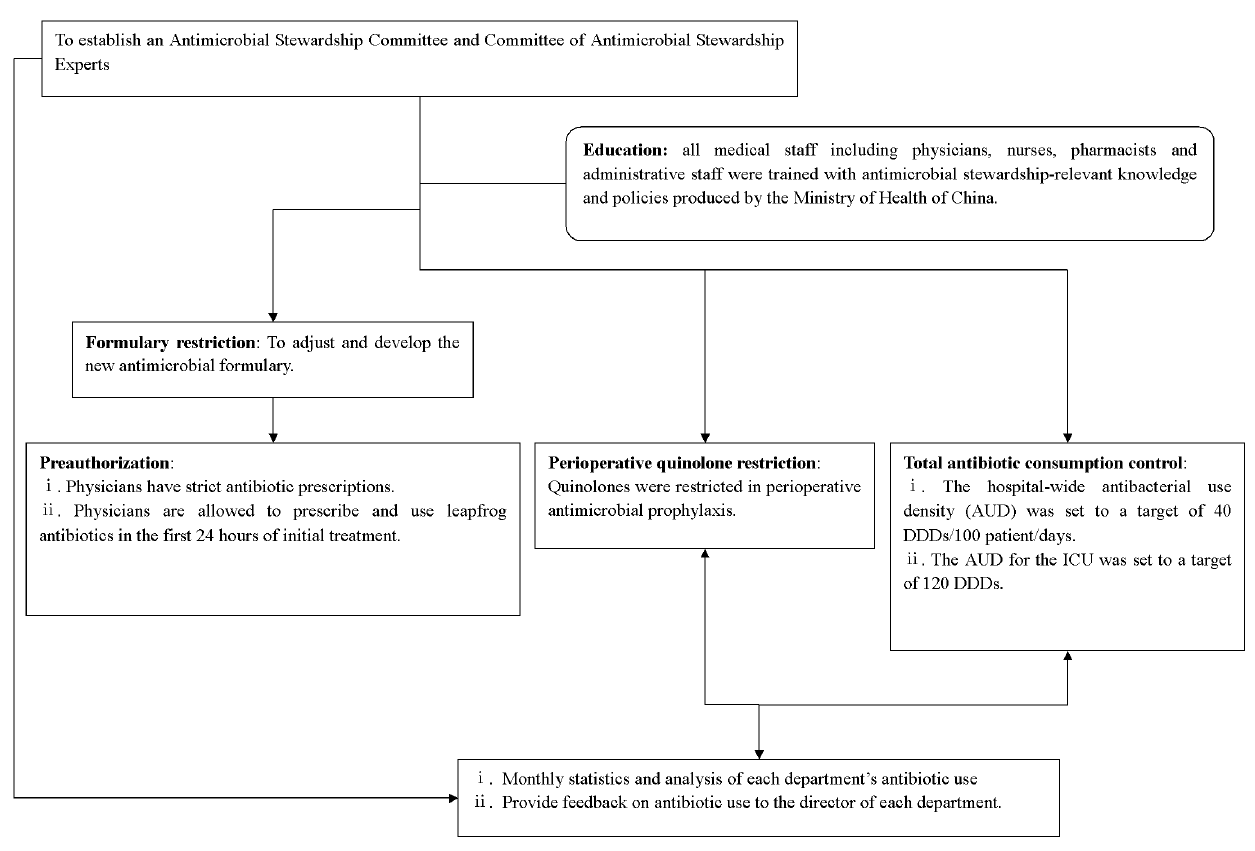
Figure 1. Flow chart of antimicrobial stewardship strategies applied in the ICU at a tertiary hospital in China. These strategies primarily included formulary restriction, preauthorization, perioperative quinolone restriction, and control of total antibiotic consumption.